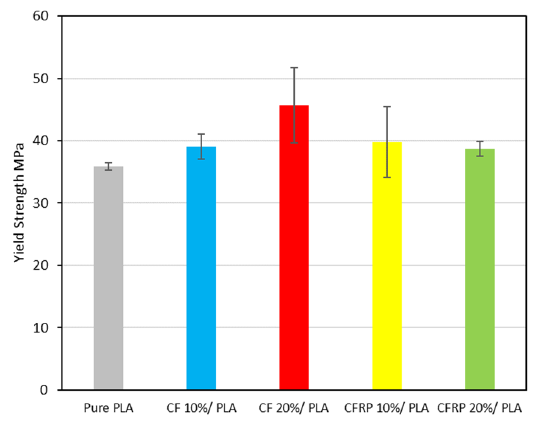
Figure 14. Yield strength for the samples.